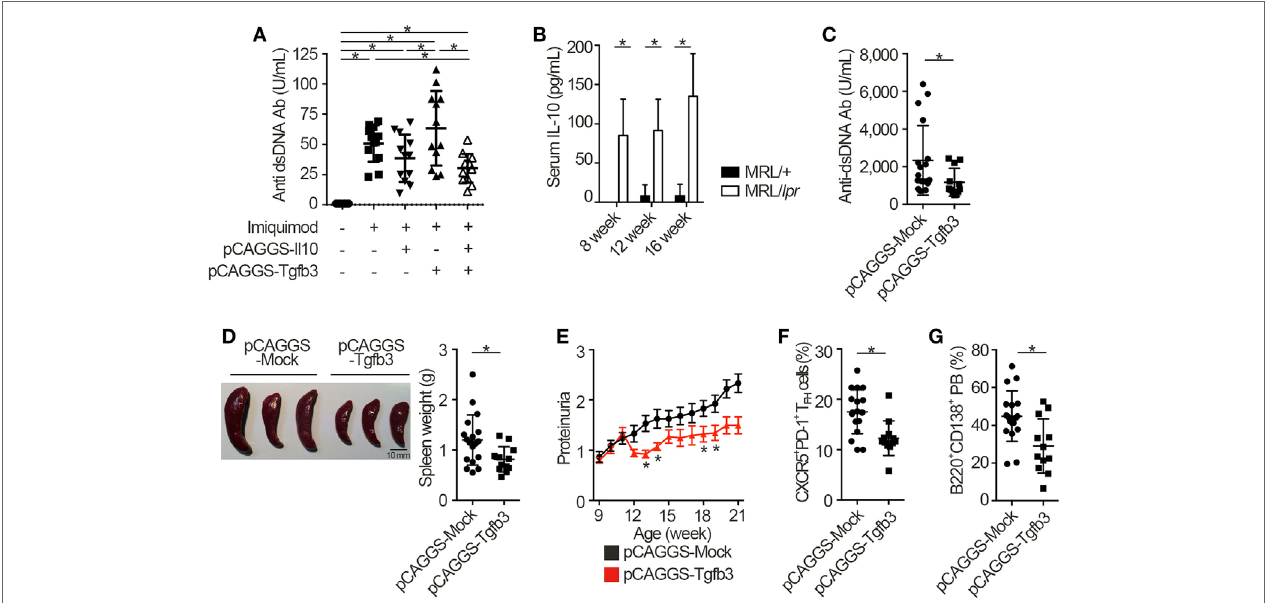
FigUre 3 | TGF- β 3 exerts therapeutic effects in mouse models of lupus under the presence of interleukin-10 (IL-10). (a) Indicated pCAGGS vectors were i.v. administered every 2 weeks to BALB/c mice treated with 1.25 mg imiquimod epicutaneously three times weekly. Serum anti-dsDNA antibody titers were quantified by ELISA ( n = 12). (B) Serum IL-10 levels in 8- to 16-week-old MRL/ + and MRL/ lpr mice were analyzed by ELISA ( n = 3). (c–g) MRL/ lpr mice treated with indicated pCAGGS vectors every 4 weeks were analyzed at an age of 21 weeks. Serum anti-dsDNA antibody levels (c) , gross appearances and weights of spleens (D) ( n = 12–18), and chronological proteinuria progression (e) ( n = 12–25). Flow cytometric quantification of CXCR5 + PD-1 + T FH cells (F) and B220 + CD138 + plasmablasts (g) ( n = 12–18). P < 0.05 by one-way analysis of variance (ANOVA) followed by Holm–Sidak’s multiple comparisons test (a) , two-way ANOVA followed by Bonferroni’s multiple comparisons test (B) , Student’s t -test (c,D,F,g) or Mann–Whitney’s U test (e) . Error bars, SD. (a–D,F,g) and SEM. (e)